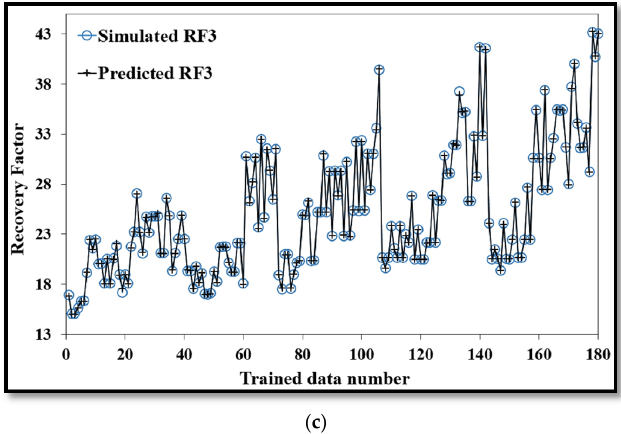
Figure 4. Comparison between simulated and predicted RF values in the training process for ( a ) RF 1 , ( b ) RF 2 , and ( c ) RF 3 . The strong correlation between the simulated and predicted data is shown in Figure 5.